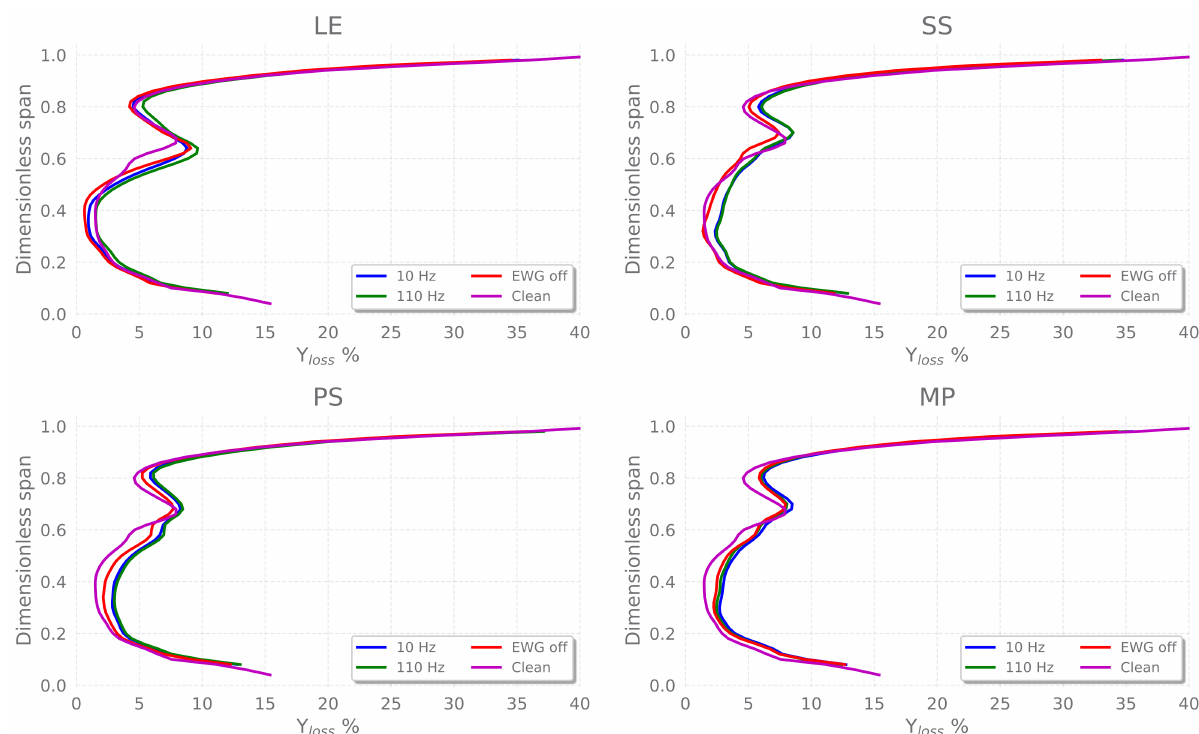
Figure 5. Circumferential mass average loss coefficient downstream of the stator (plane T2) at different injection positions. Measurements are carried out with EWG switched off (“EWG off”), injecting EW at 10 and 110 Hz (“10 Hz” and “110 Hz” respectively) and without the EWG in exploiting uniform inlet condition